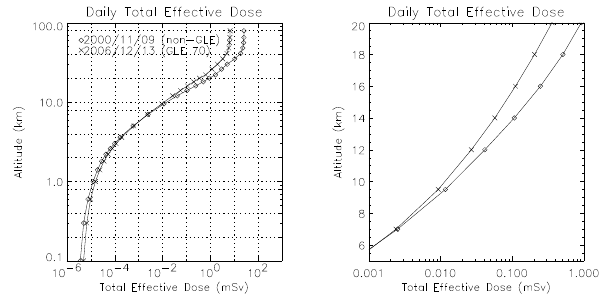
Figure 4. Simulated total effective dose at various altitudes dur- ing the non-GLE event (diamonds) and during the GLE-70 event (crosses) for